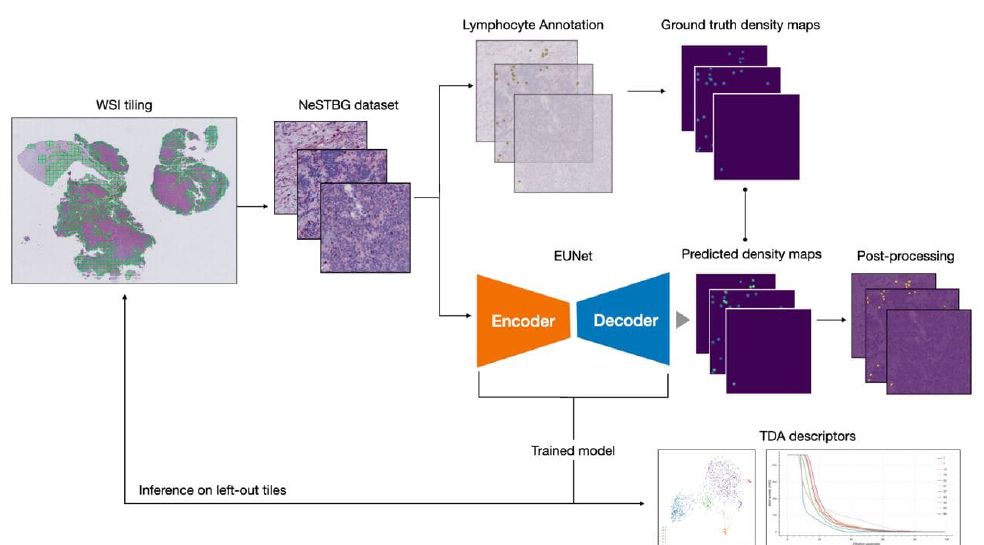
Figure 1. Graphical representation of the full analysis workflow. From the original WSIs, the collection of tiles constituting the NeSTBG dataset is generated and annotated to obtain the ground truth for the model (Section 4.1). Tiles are then used as the input for the DL architecture EUNet (Sections 4.2 and 4.3) to predict density maps (Section 4.4), that are then post-processed and analysed via TDA descriptors to interpret the detected deep features (Section